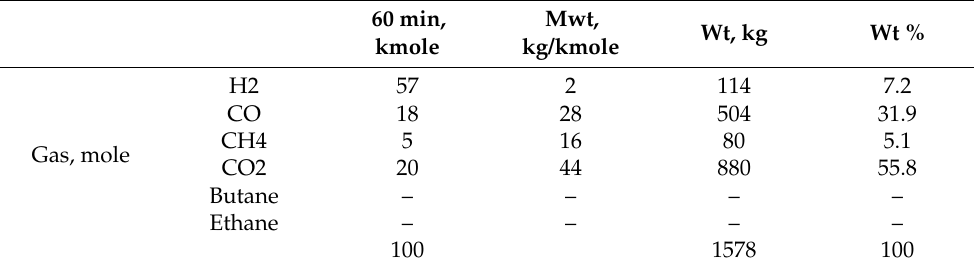
Table 29. Converting mole per cent to weight per cent—gasification at 900 ◦